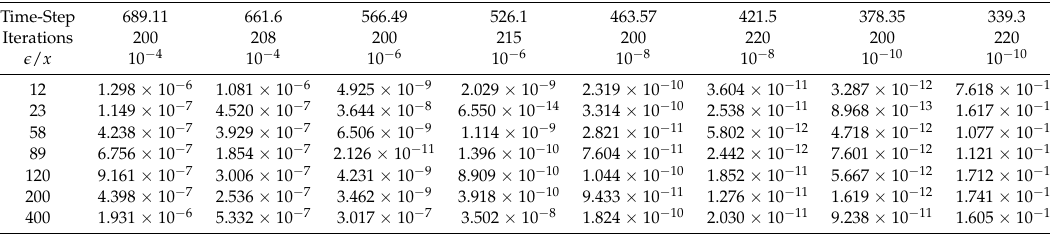
Table 1. Results of the comparison of the time-step criteria.